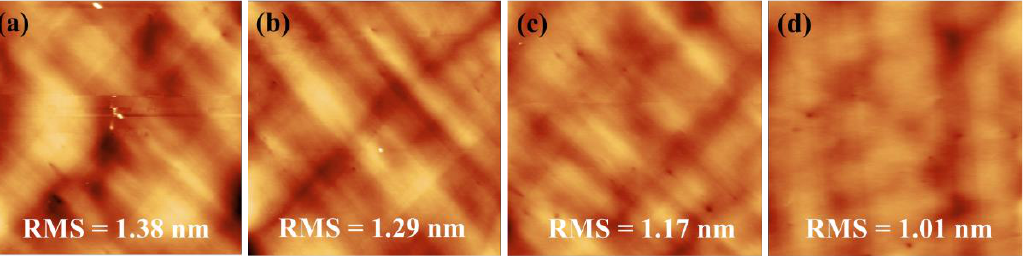
Figure 4. AFM image of the GaAs buffer at different growth stages as marked in Figure 3a as: ( a ) labeled B; ( b ) labeled C; ( c ) labeled D; and ( d ) labeled E. The scans were performed for 10 × 10 µ m 2 areas on the sample.